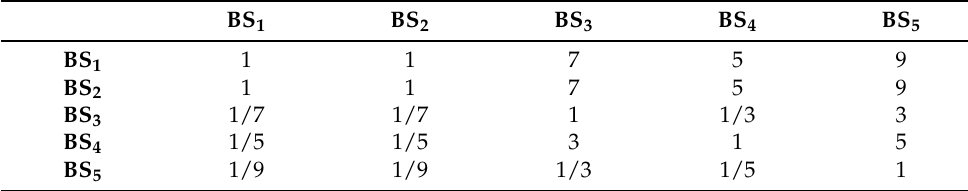
Table A9. The pairwise comparison matrix User _ C 2 .